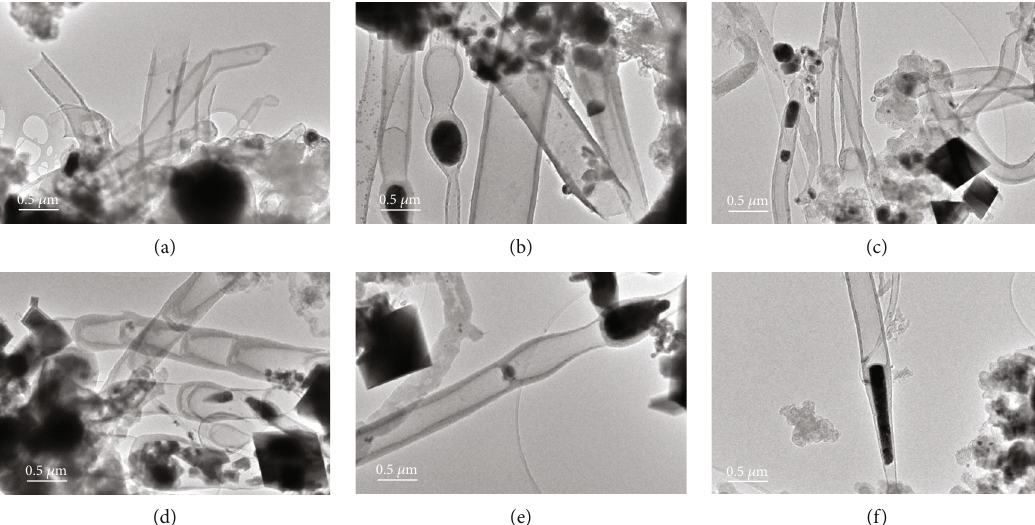
Figure 5: Di ff erent morphologies can be observed for the CNTs synthesized by 90 s microwave time, such as straight tubes with continuous tube walls (a), bamboo-shaped tubes with segmented tube walls (b), curved tubes with continuous tube walls (c), and cup-stack tubes (d). A few large rhombohedral and rectangular NPs can be observed in (c), (d), and (e), indicating substantial Ostwald ripening of the catalysts. Protruding (e) and liquid-shaped (f) catalyst Fe NPs can be observed at the tips of the as-obtained CNTs, indicating the same growth mode with the 30s and 60 s